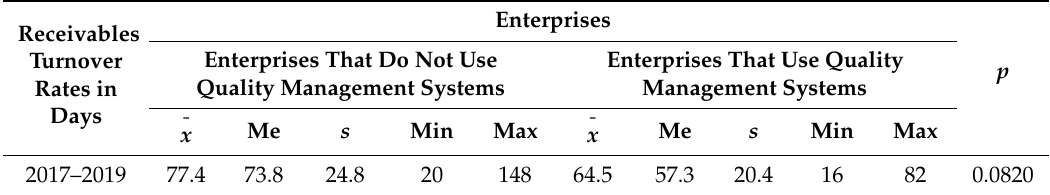
Table 5. Average results for receivables turnover rates in days.